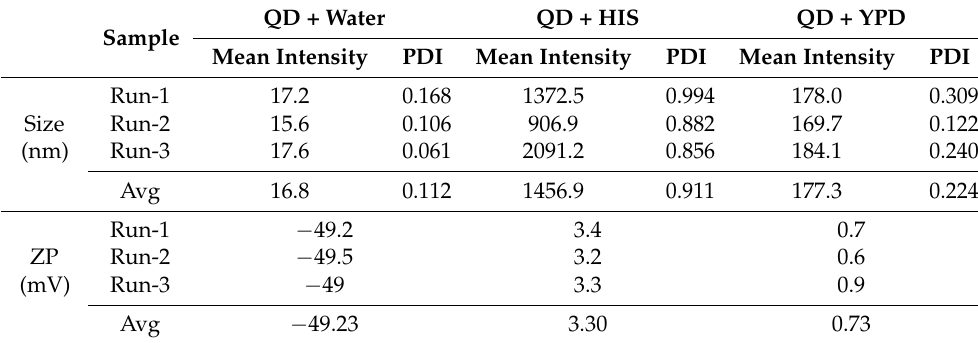
Table 2. Mean size and zeta potential of QDs in water, nutrient-lacking histidine media ( − His +Glu), and yeast peptone dextrose media (YPD) using DLS. The polydispersity index (PDI) value is also provided. PDI that is less than 0.1 represents a highly monodisperse sample, usually a clean standard. In contrast, a PDI value greater than 0.7 indicates that the sample has a very broad size distribution and may have agglomerations. QD + Water QD + HIS QD + YPD Sample Mean Intensity PDI Mean Intensity PDI